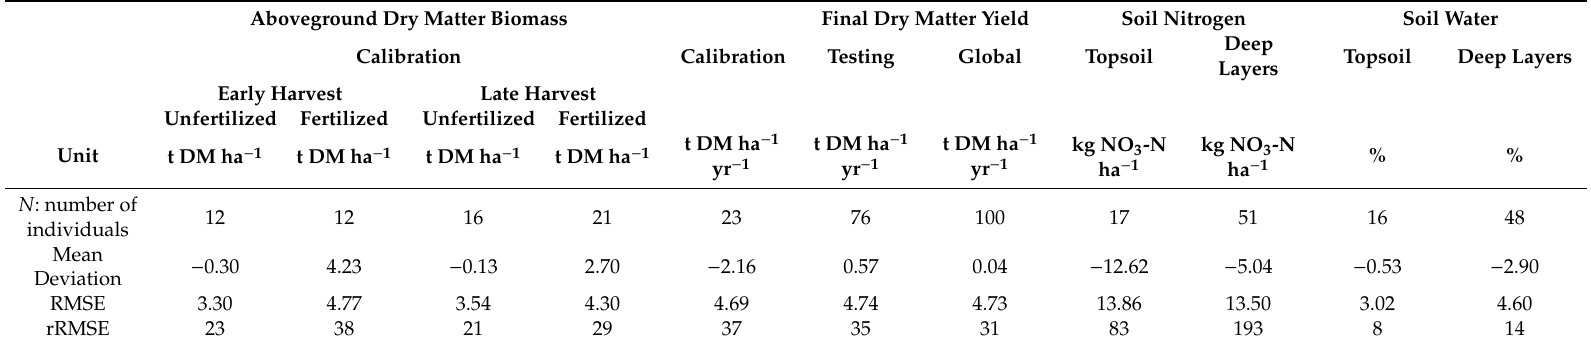
Table 4. Goodness of fit statistics for the simulation of the miscanthus